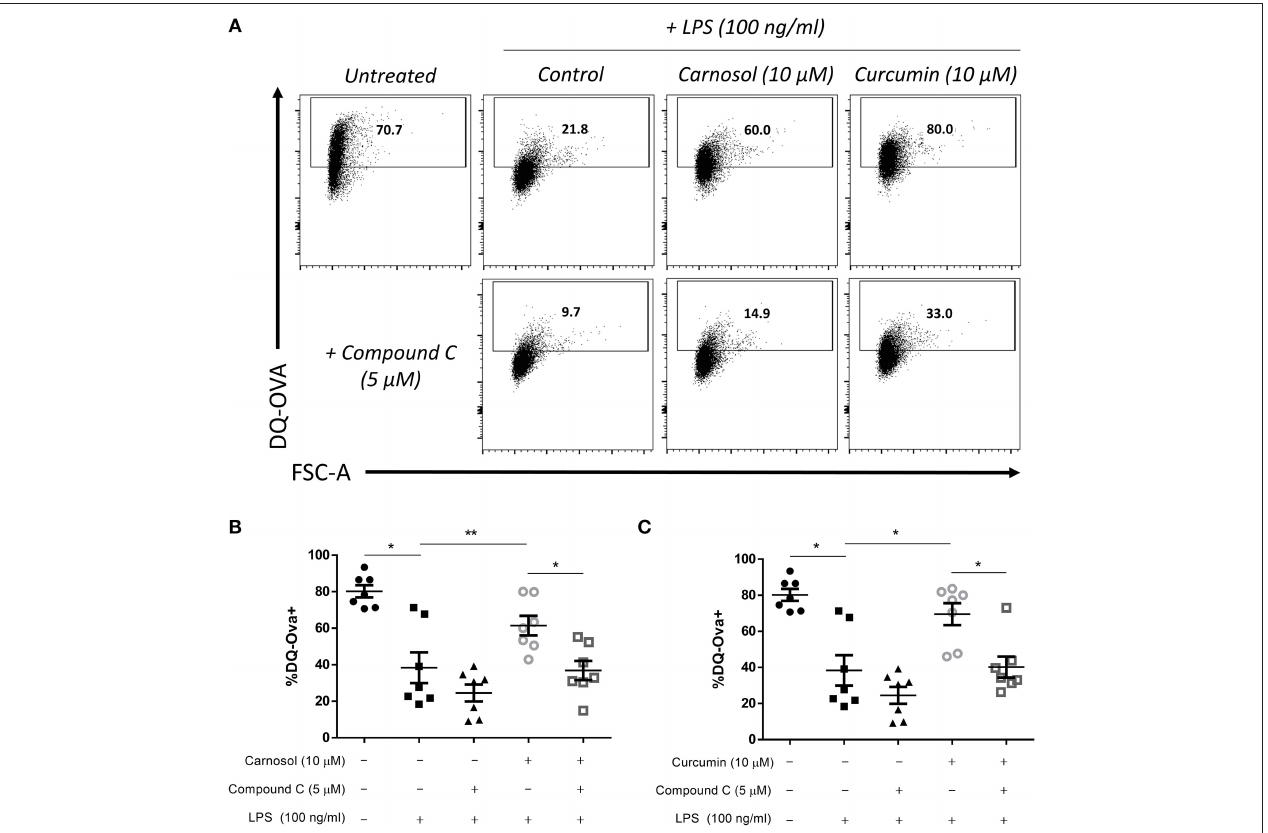
FIGURE 5 | Inhibition of AMPK attenuates the increased phagocytic capacity of LPS-stimulated DC treated with carnosol or curcumin. Primary human DC ( n = 7) were incubated with or without compound C (5 µ M) for 1h, then treated with carnosol (10 µ M), curcumin (10 µ M) or a vehicle control for 6h prior to stimulation with LPS (100ng/ml) for 24h. DC were then incubated with DQ-Ovalbumin (DQ-Ova; 500ng/ml) for 20min prior to analysis by flow cytometry. (A) Representative dot plots depicting DQ-Ova uptake by DC treated with carnosol, curcumin, and compound C from one representative experiment. Pooled data ( n = 7) depicts percentage DQ-Ova uptake of DC treated with (B) carnosol or (C) curcumin, with or without compound C. Results shown are mean ( ± SEM) percentages of DQ-Ova uptake in control-, carnosol- and curcumin-treated DC, with or without compound C. Statistical significance was determined by repeated measures one-way ANOVA, with Tukey’s multiple comparisons post hoc test to compare means of all groups (** p < 0.01, * p <